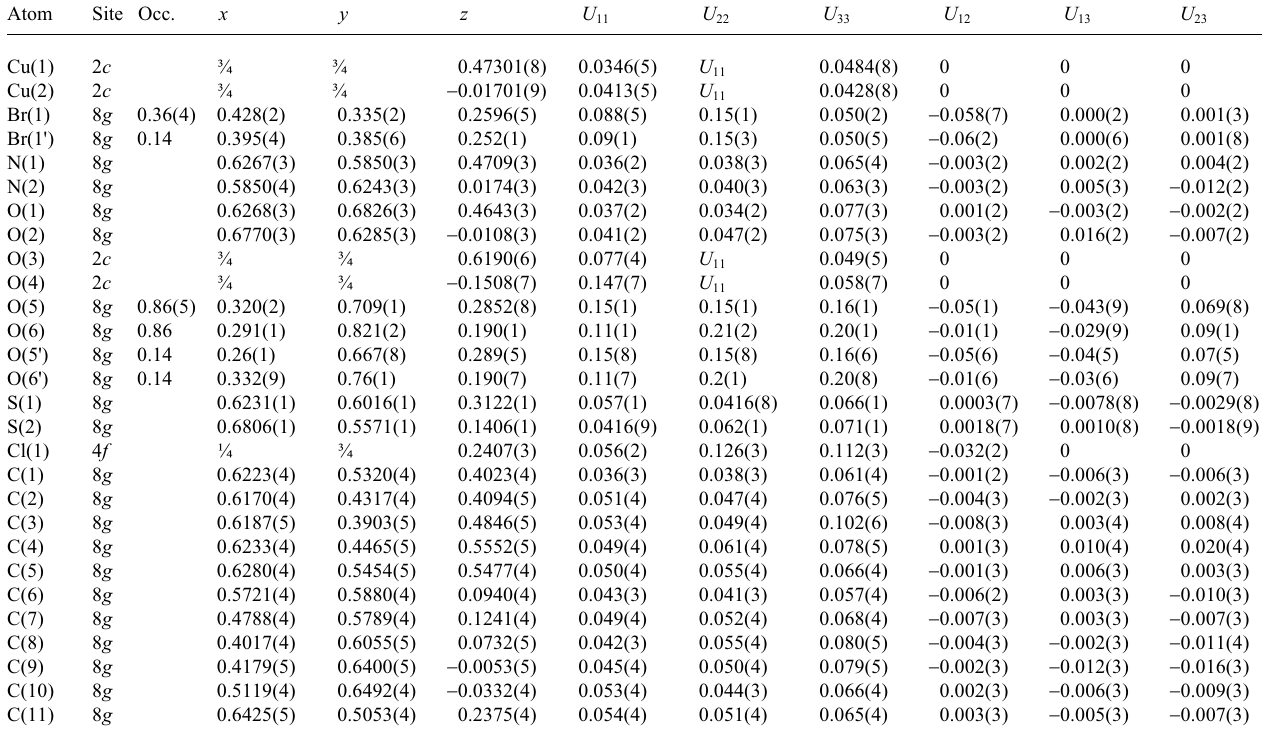
Table 3. Atomic coordinates and displacement parameters (in Å 2 ).